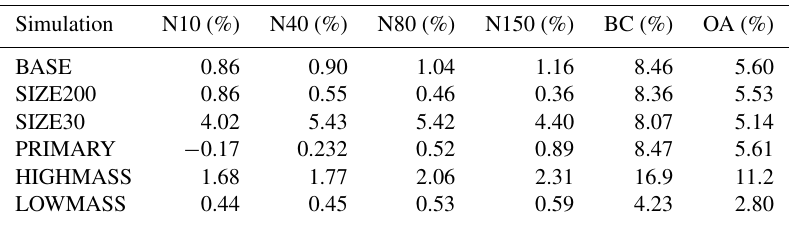
Figure 2. One-to-one plots of time-averaged AOD for BASE (a, c, e) and WASTE_OFF (b, d, f) compared to AERONET observations at 380nm (a, b) , 500nm (c, d) , and 1020nm (e, f) . The values in the box give the slope of the linear regression (m), the correlation ( r 2 ) , and the log-mean bias (LMB), while the black dashed line represents the 1 : 1 line and the red line is the result of the linear regression. Table 2. Percent change in global, annual-mean N10, N40, N80, N150, BC mass, and OA mass from domestic-waste combustion (i.e., relative to WASTE_OFF